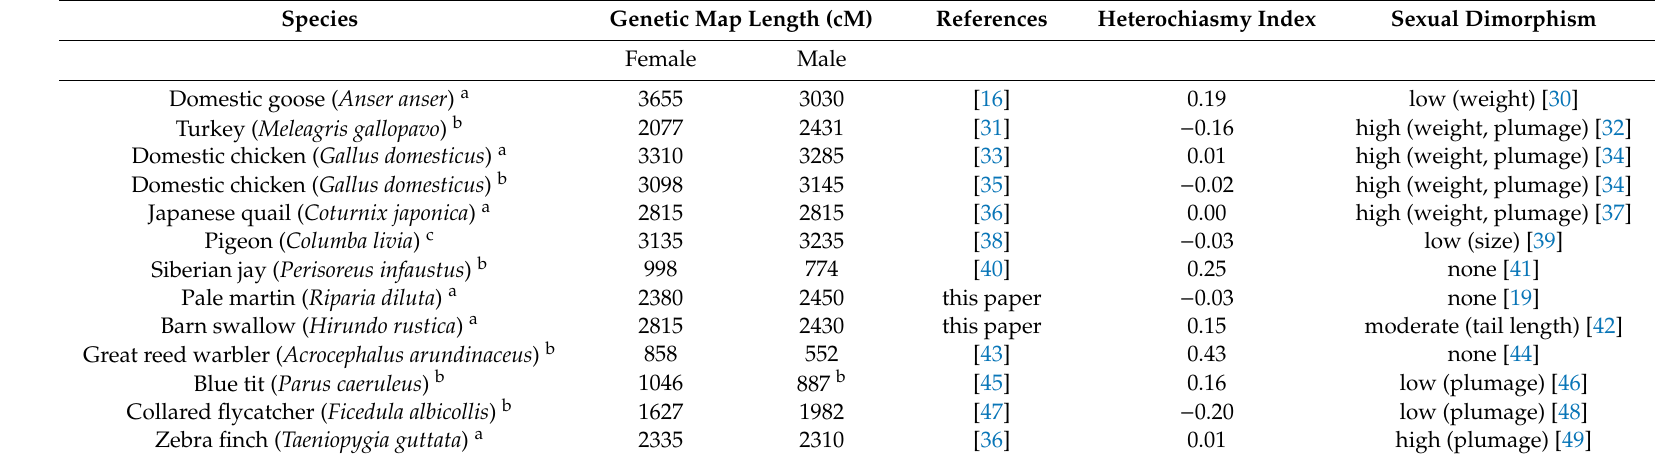
Table 3. Heterochiasmy and sexual dimorphism in